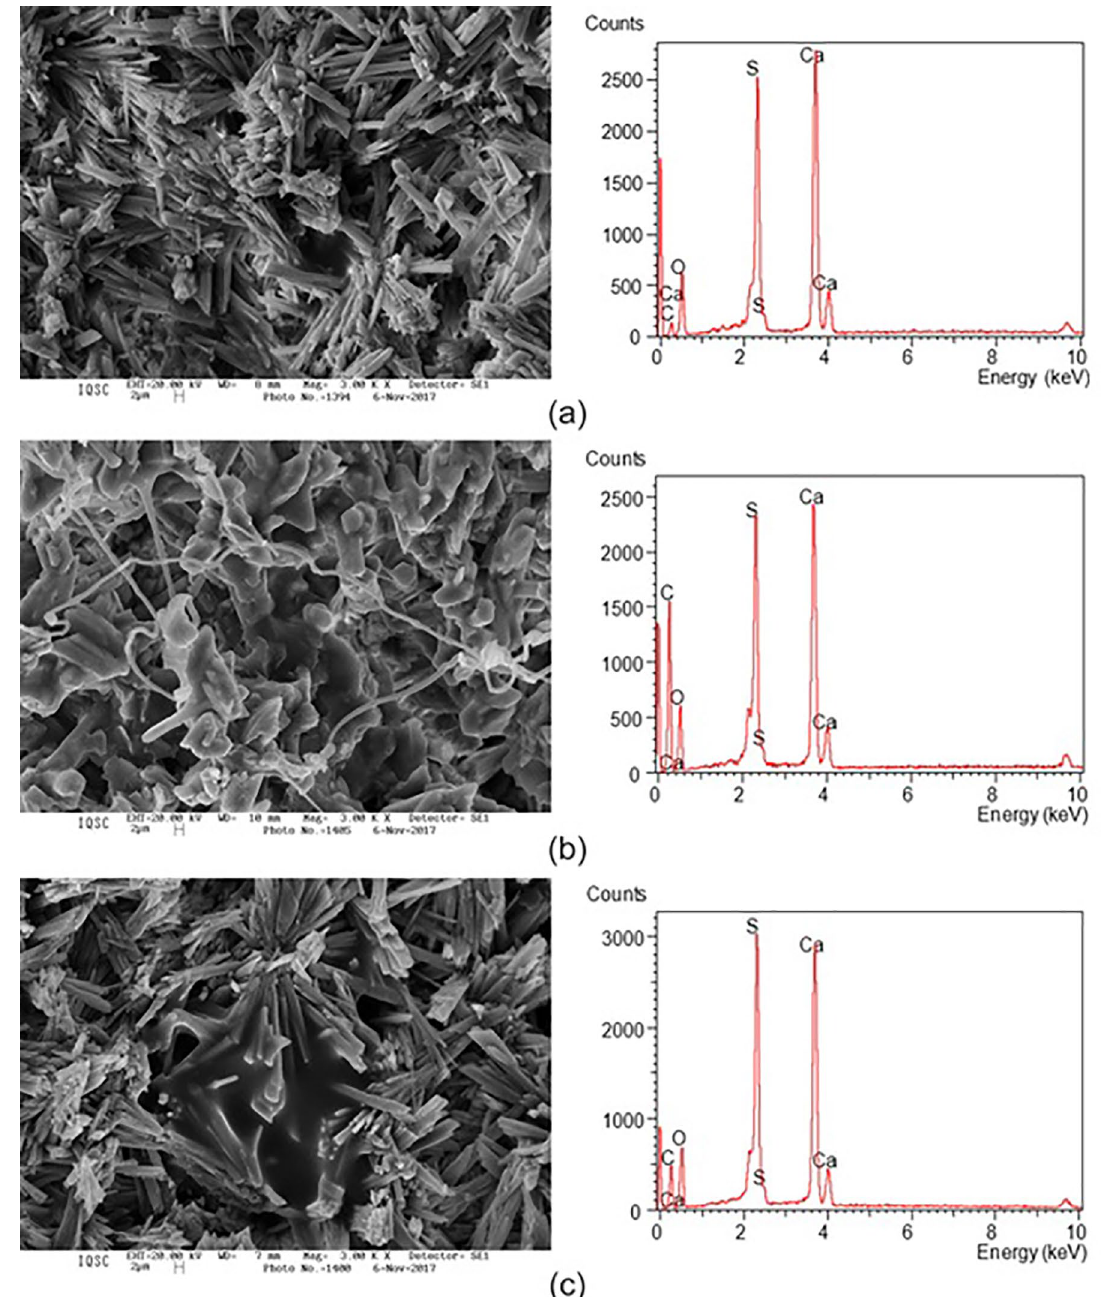
Figure 6. SEM and EDS of the sample with addition of 5% polymer: (a) EVA; (b) VA/VL/VC; (c)